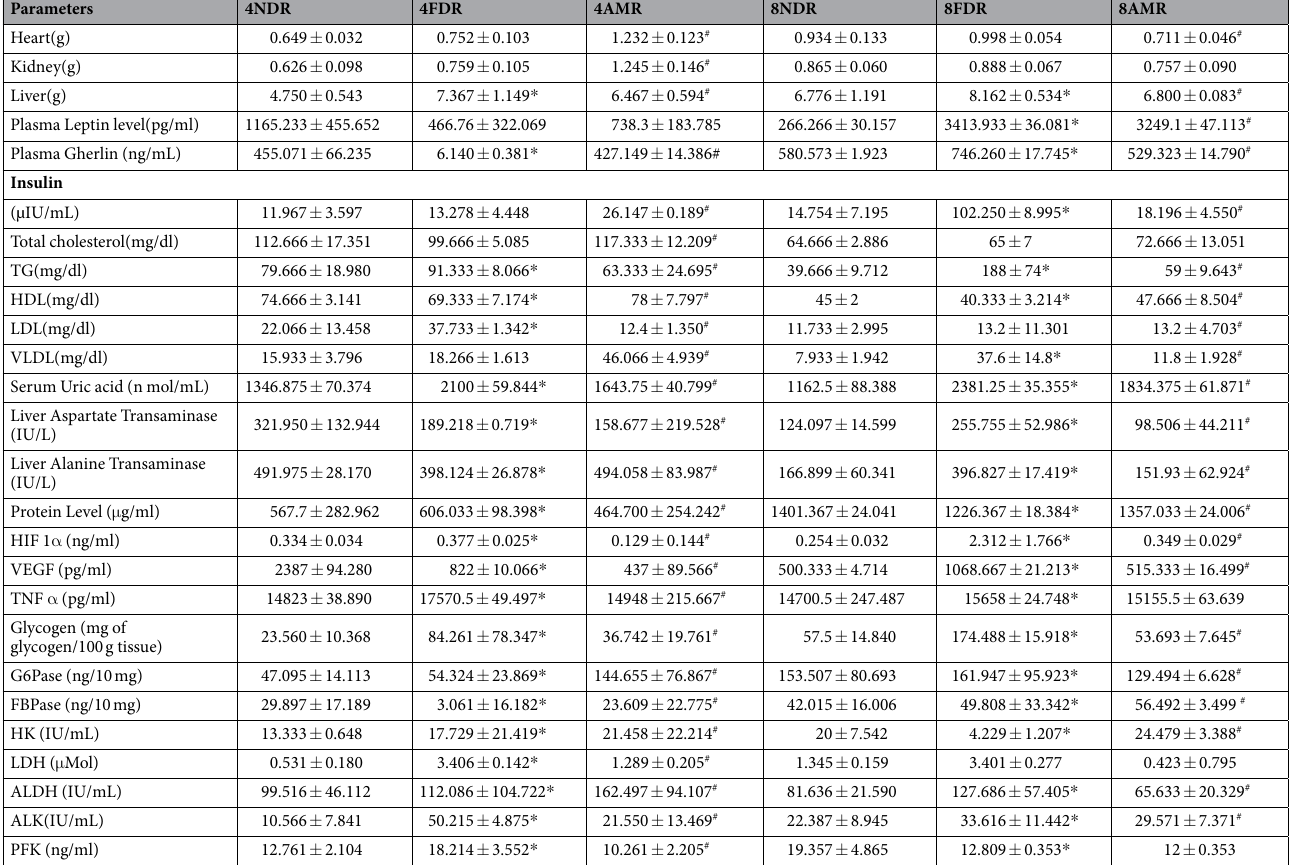
Table 1. Comparison of visceral weight, lipid profile, liver function test, activities of pro-inflammatory markers and enzymes of glycolysis and gluconeogenesis after 4 weeks(study I) and 8 weeks (study II) of fructose ingestion. The rise in weight of liver, insulin concentration, triglyceride level, glycogen content, pro- inflammatory markers after fructose ingestion, is phenomenal at developing than at adulthood stage. All values are mean ± SEM; (n = 6), * p < 0.05 vs NDR, #p < 0.001 vs